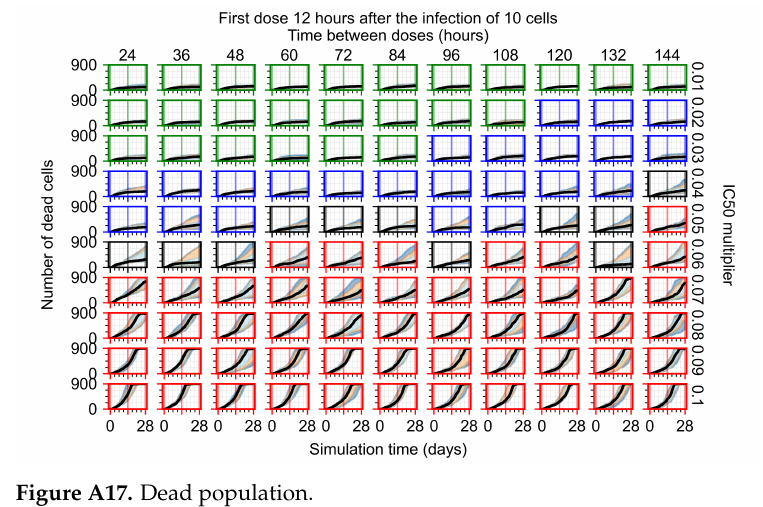
Figure A17. Dead population.